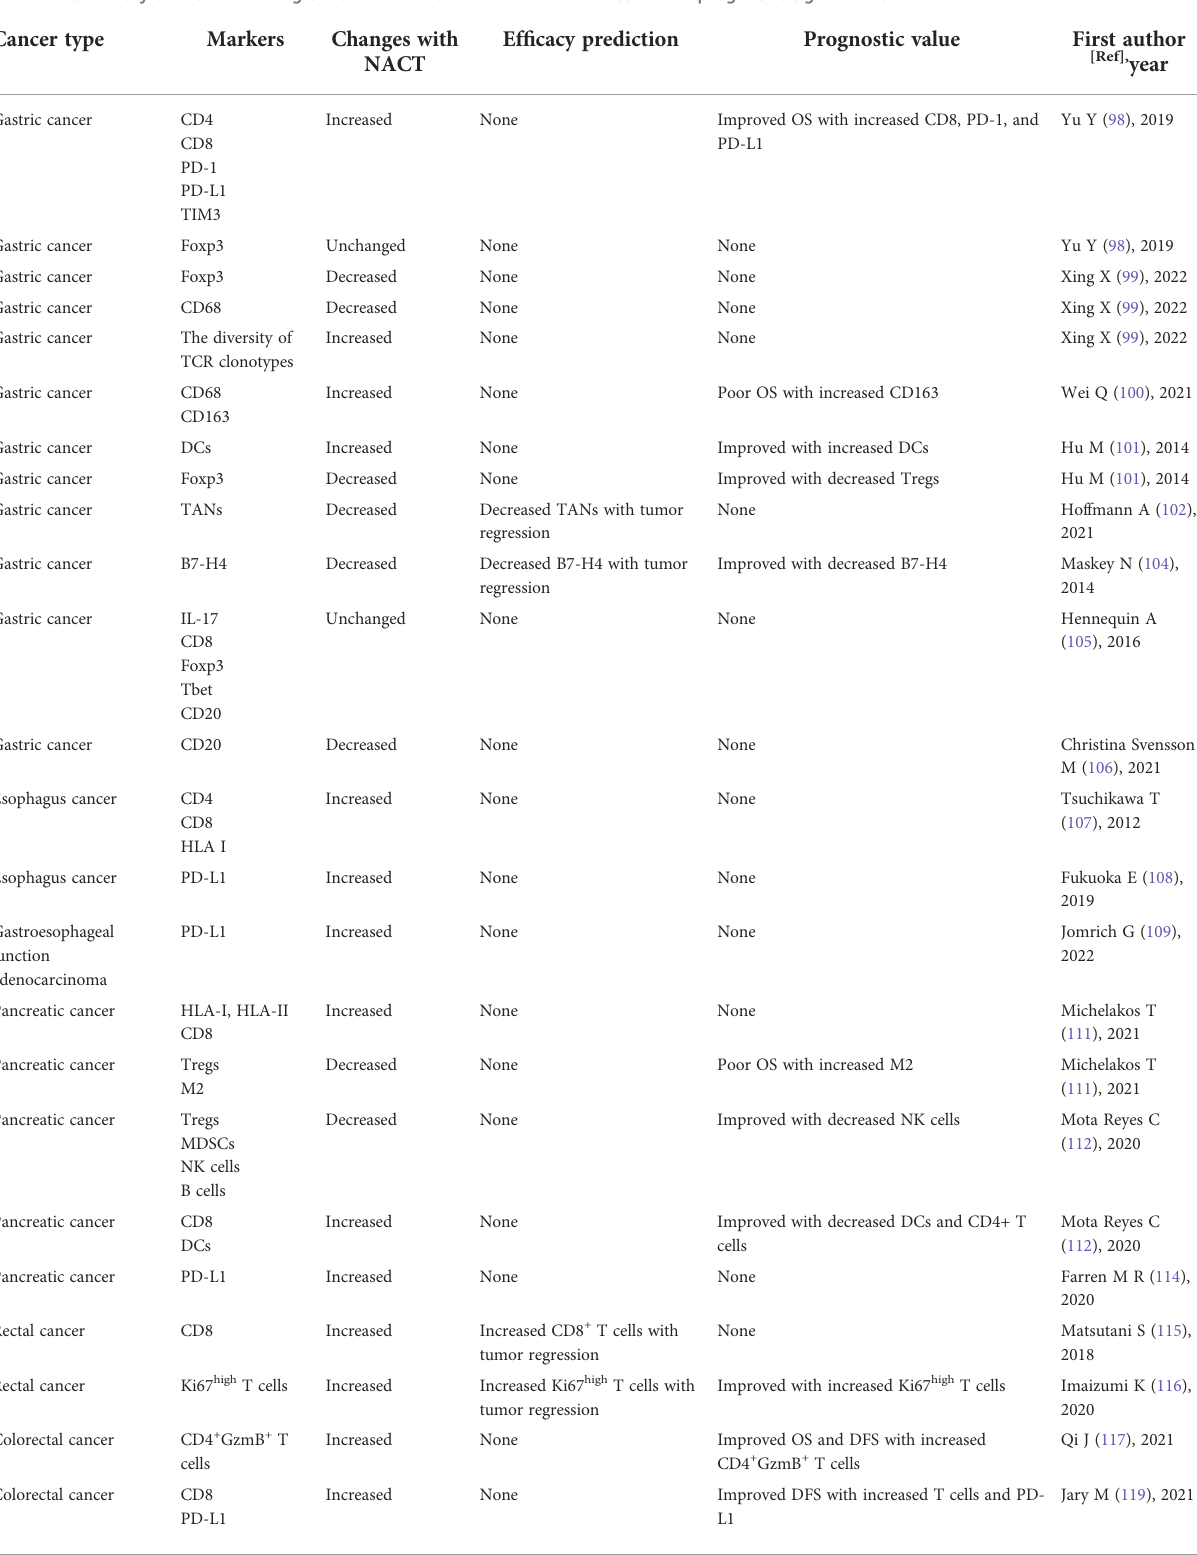
TABLE 1 Summary of the remodeling effect of NACT on the TIME and the associated prognostic signi fi